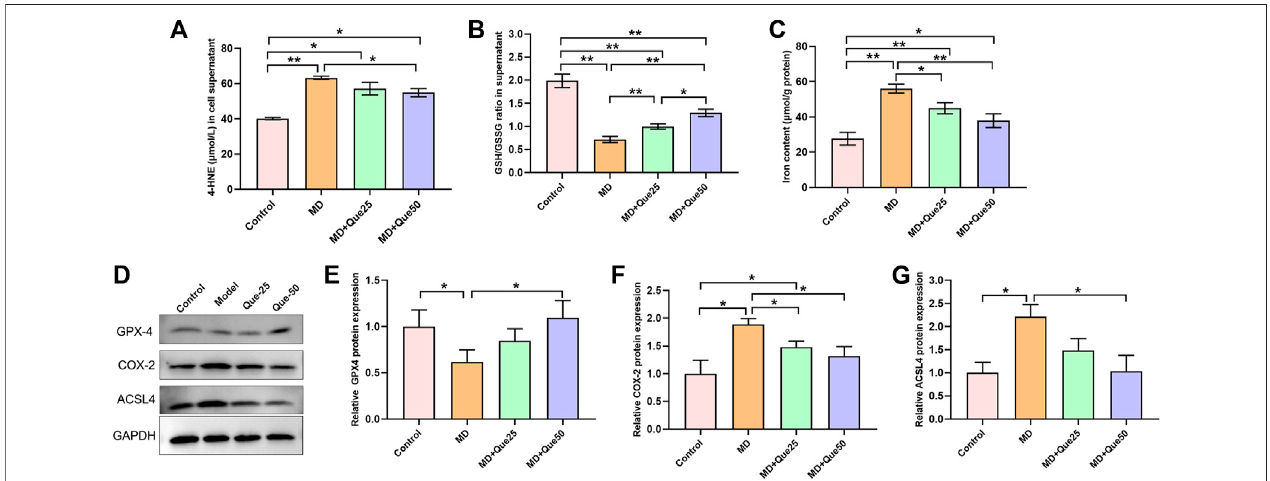
FIGURE5| QuesuppressedlipidperoxidationandferroptosisinsteatoticL-02cells. (A,B) Therelativecontentsof4-HNEandGSH/GSSGinL-02cells( n =3). (C) Ironcontentincells( n =3). (D) RepresentativeWestern blotimages. (E – G) Theexpression offerroptosis-relatedproteins(GPX4,COX-2andACSL4)inL-02cells( n =3). The data are expressed as the mean ± SD from three independent experiments. pp p < 0.01 and p p < 0.05.